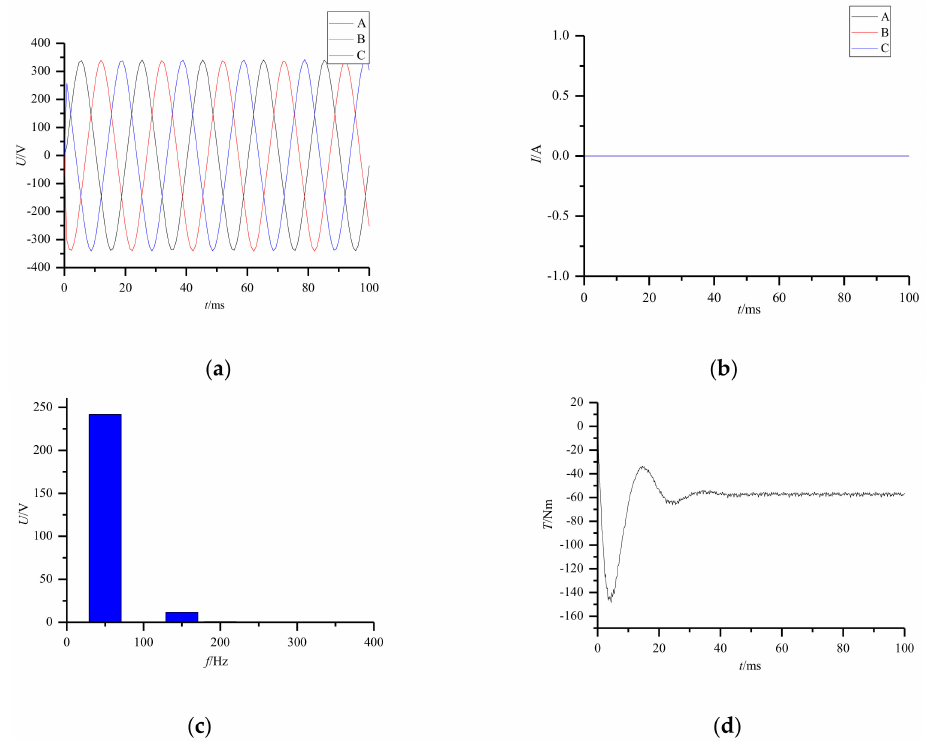
Figure 6. Electrical parameter variation curve of the no-load generator: ( a ) Stator voltage; ( b ) Stator current; ( c ) Terminal voltage harmonic distribution; ( d ) Electromagnetic torque.